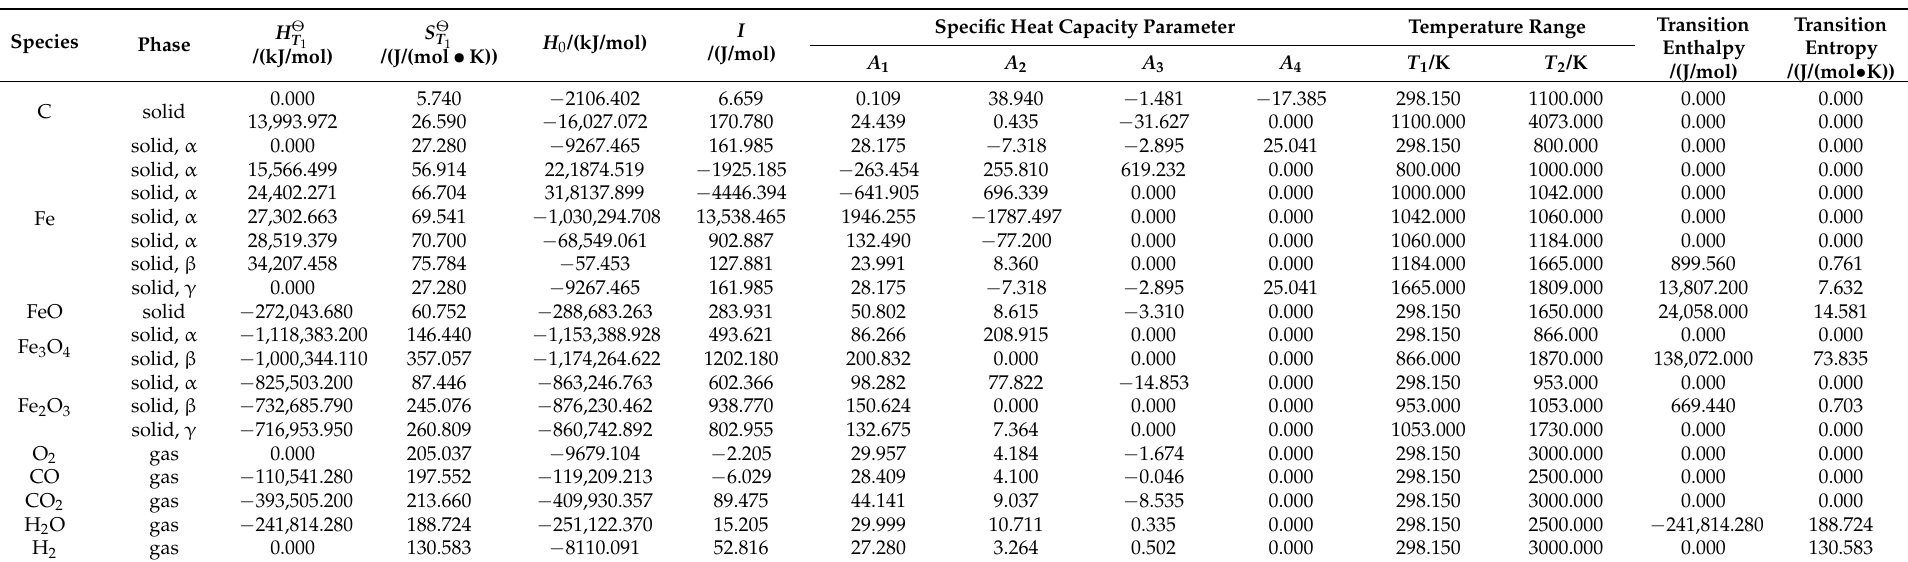
Table 2. Thermodynamic parameters calculated by mathematical